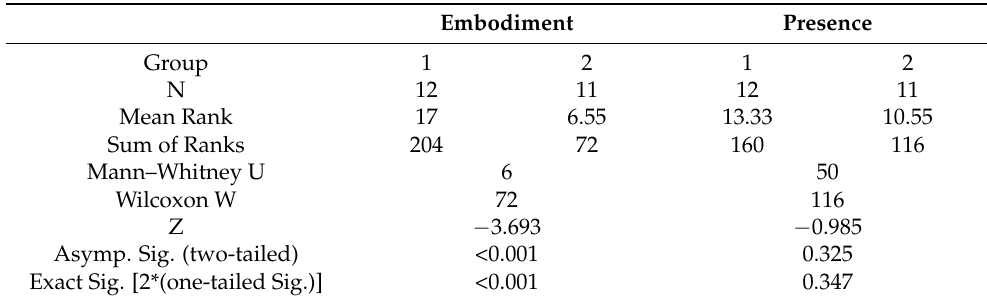
Table 5. Results of the Mann–Whitney U test on presence and embodiment between Group 1 and Group